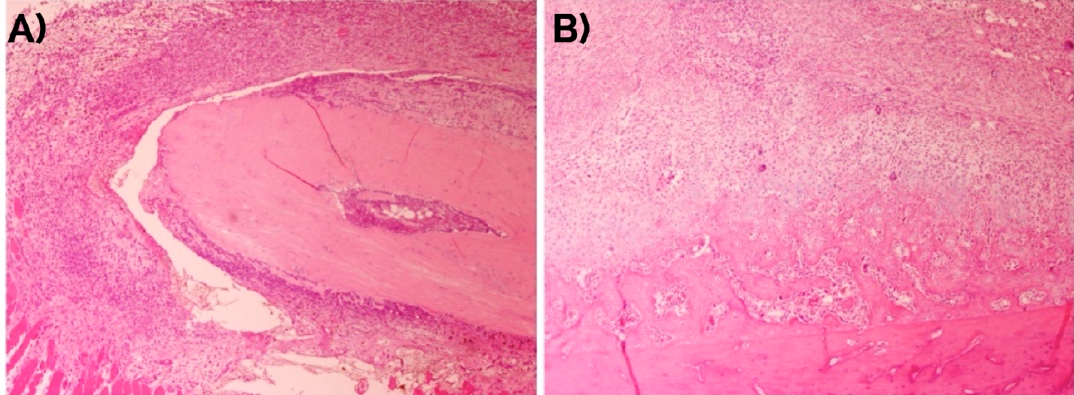
Figure 1. Evolution of the bone fracture callus at days ( A ) 4 and ( B ) 7. Hematoxylin-eosin. Original magnification: 4×.